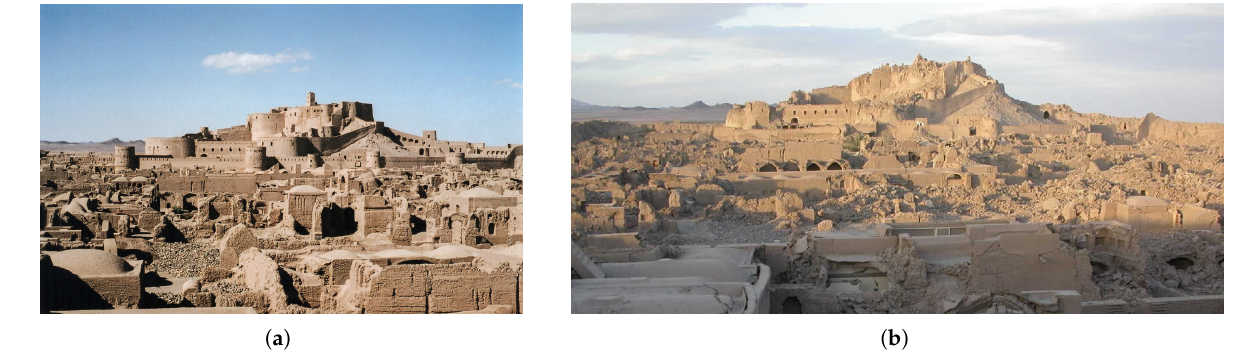
Figure 7. Bam citadel; ( a ) before the 2003 Earthquake; ( b ) after the earthquake